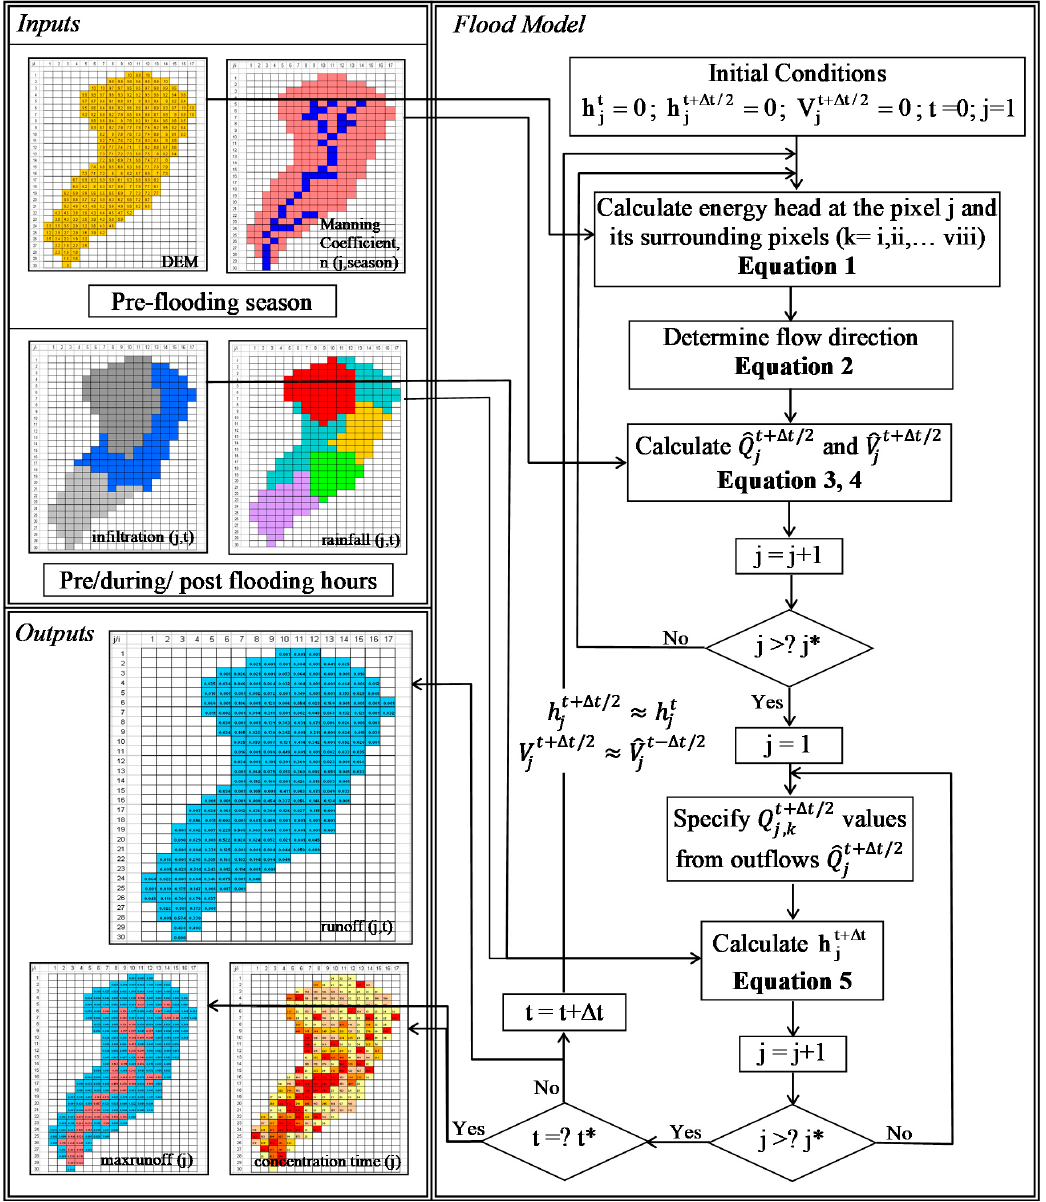
Figure 3. The algorithm for simulation of rainfall-induced floods.